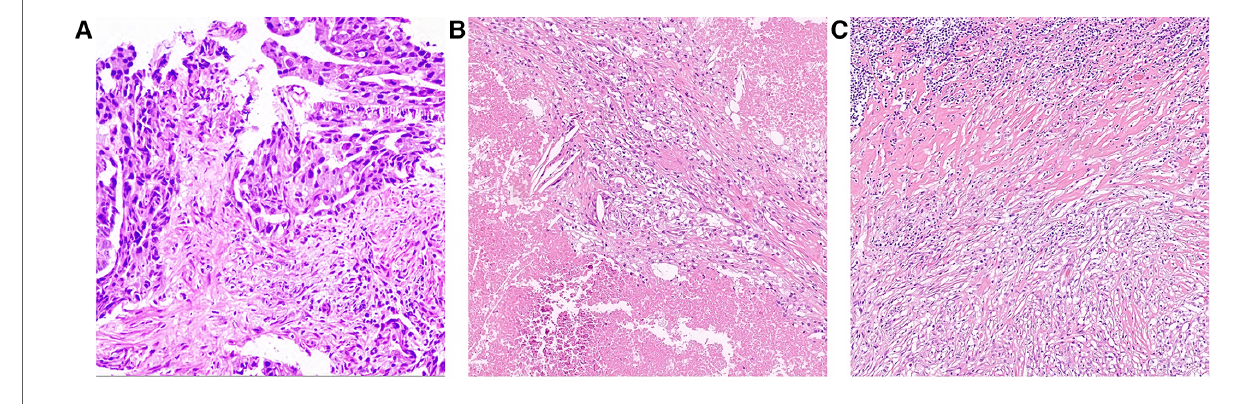
FIGURE 2 Pathological fi ndings ( A ) Endoscopic biopsy before chemo-immunotherapy at local hospital (Hematoxylin-eosin staining, magni fi cation ×10); ( B ) Tumor area and ( C ) lymph node after 3 courses of chemo-immunotherapy (Hematoxylin-eosin staining, magni fi cation ×10).